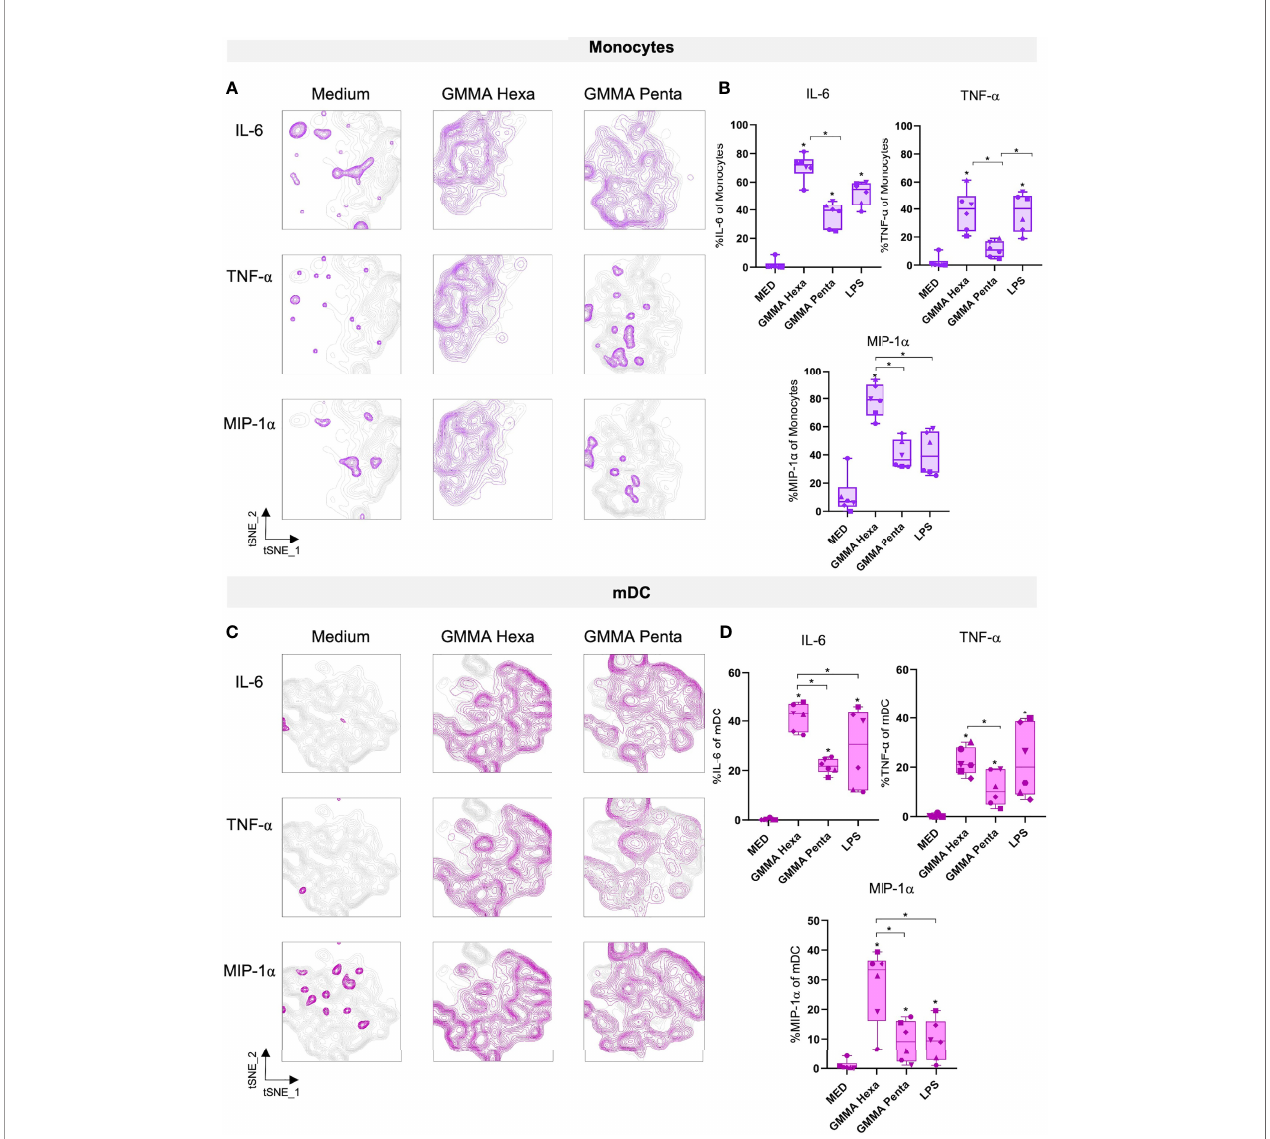
FIGURE 3 | Intracellular cytokines production after 22 hours of stimulation with GMMA. (A – C) t-SNE projections of two different cell populations, i.e. monocytes and mDC, showing intracellular cytokines production after stimulation with GMMA Hexa and GMMA Penta. Medium and MED are used as synonyms for control samples. (B – D) Percentages of cells producing the analyzed cytokines. Percentage were calculated on the manually gated cell populations. The different dots represent the six different donors. Signi fi cance was estimated using the paired Wilcoxon test (*p < 0.05). Signi fi cant differences with respect to the negative control are indicated on top of each box, instead signi fi cant differences among stimuli are shown explicitly. Non-signi fi cant differences are not